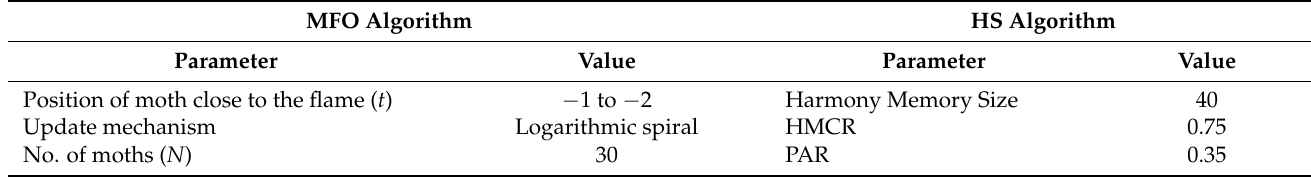
Figure 1. Pseudocode of MFO and HS algorithms. Table 1. Parameters and their values used in MFO and HS